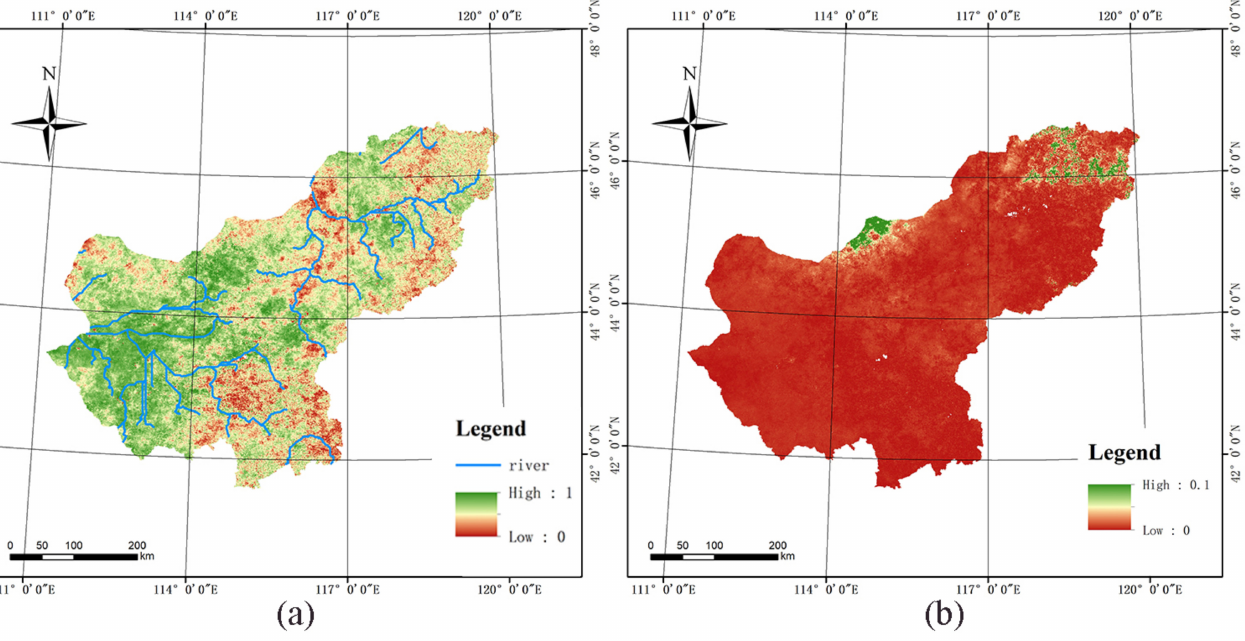
Figure 5. Spatial distribution of the correlations between the interannual variations of the NDVI and the interannual variations of the climate elements ( a ) precipitation and ( b )